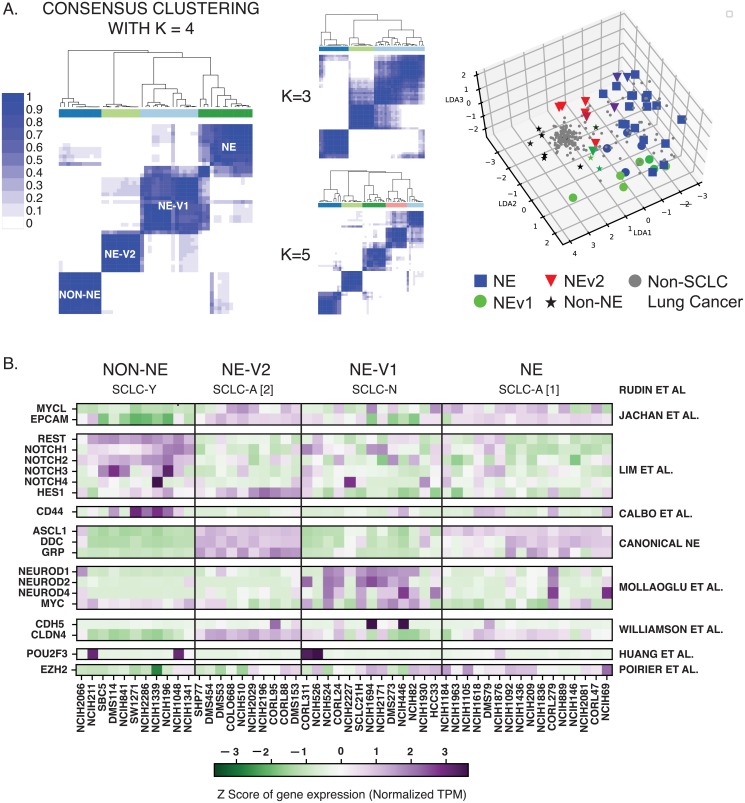
Consensus clustering and WGCNA of 50 SCLC cell lines reveals four subtypes differentiated by gene modules.A. Consensus clustering with k = 4 gives most consistent clusters. K = 3 and K = 5 add complexity without a corresponding increase in accuracy. LDA plot shows separation of 4 clusters, with non-SCLC cell lines falling near non-NE cell lines. B. Current biomarkers in the field of SCLC are able to distinguish between three of the subtypes; The fourth subtype, NEv2, is not separable from NE using markers from SCLC literature.